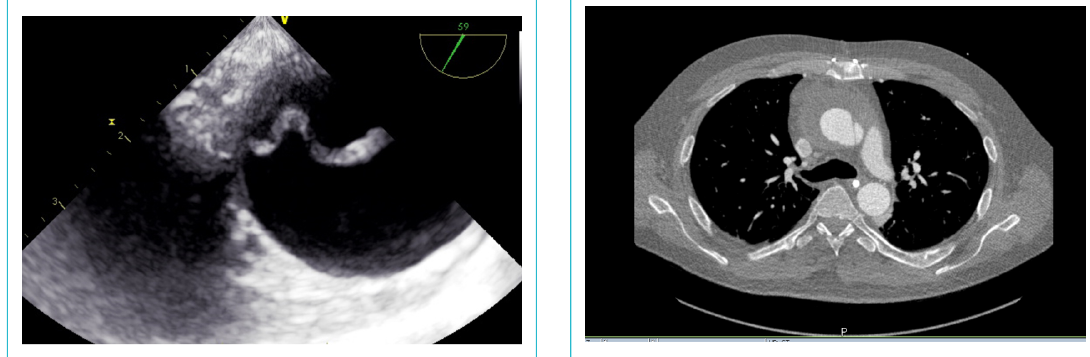
Figure 2: Transoesophageal echocardiographic image of the inti- mal flap in type A dissection.